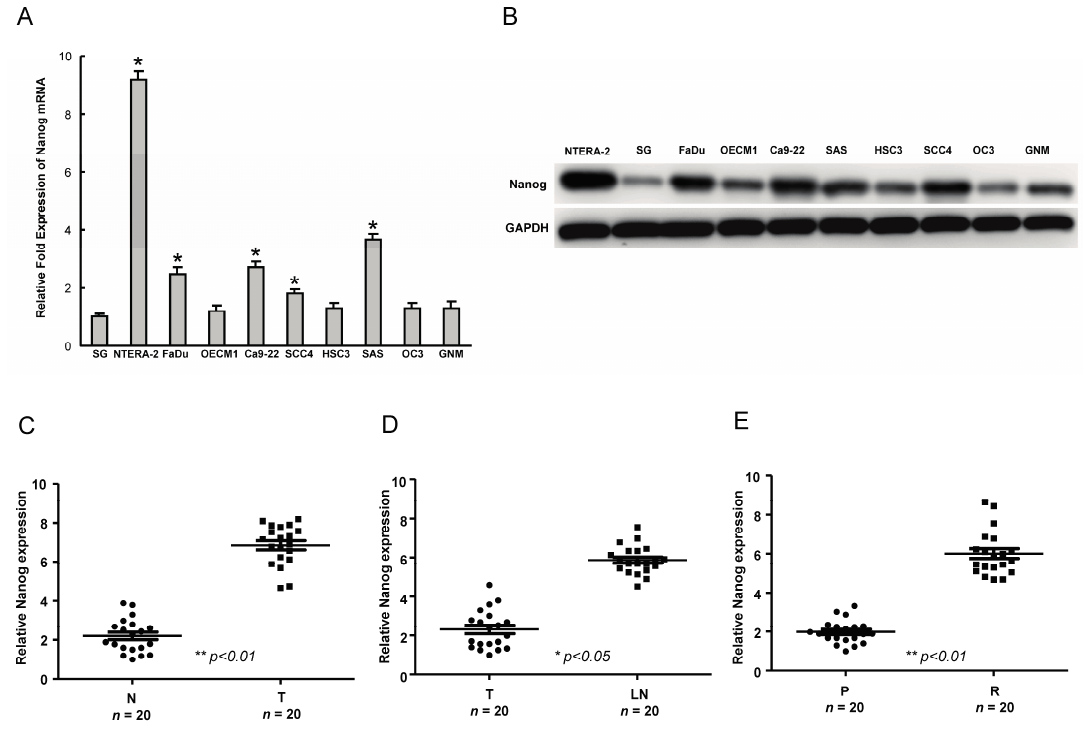
Figure 1. Determination of Nanog expression in head and neck squamous cell carcinomas (HNSCC) cells and HNSCC specimens. Nanog transcript ( A ) and protein ( B ) expression in eight HNSCC lines and one normal oral epithelial cell (SG) and one human embryonal carcinoma cell line (NTERA-2) were examined by real-time RT-PCR analysis and western blotting. The amount of GAPDH protein of different crude cell extracts was considered the loading control; ( C ) Quantitative RT-PCR analysis of Nanog expression levels in clinical specimens from a non-tumor region (N) or a tumor region (T); ( D ) Analysis of Nanog expression levels in primary and lymph node metastatic HNSCC tissues; and ( E ) Quantitative RT-PCR analysis of Nanog expression levels in clinical specimens from primary (P) and recurrent (R) HNSCC patients. * p < 0.05; ** p <